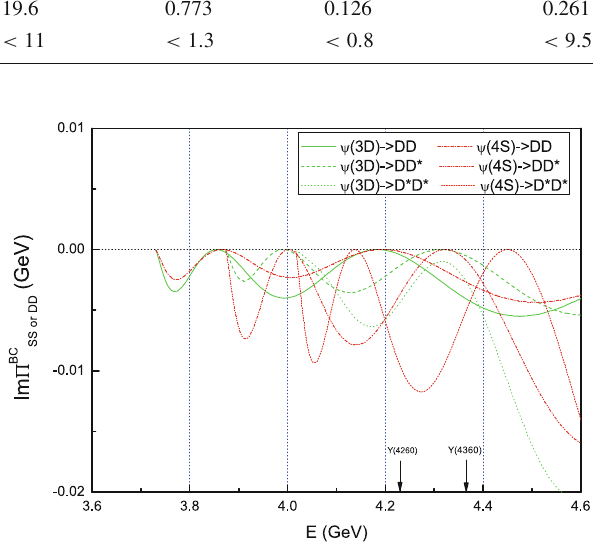
Fig. 4 Im (cid:6) BC and Im (cid:6) BC of D ¯ D , D ¯ D ∗ + c . c . and D ∗ ¯ D ∗ SS DD